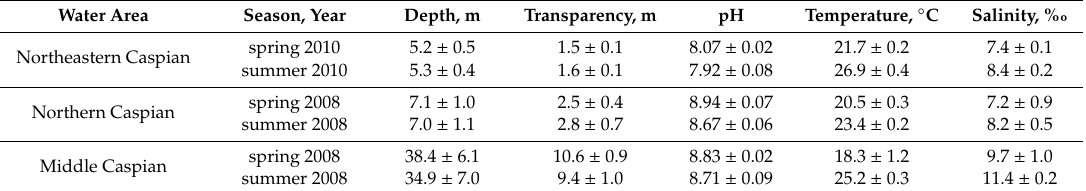
Table 1. Hydrophysical and hydrochemical characteristics of the studied water area of the Caspian Sea (mean with standard error). Depth, m Salinity, % (cid:24)